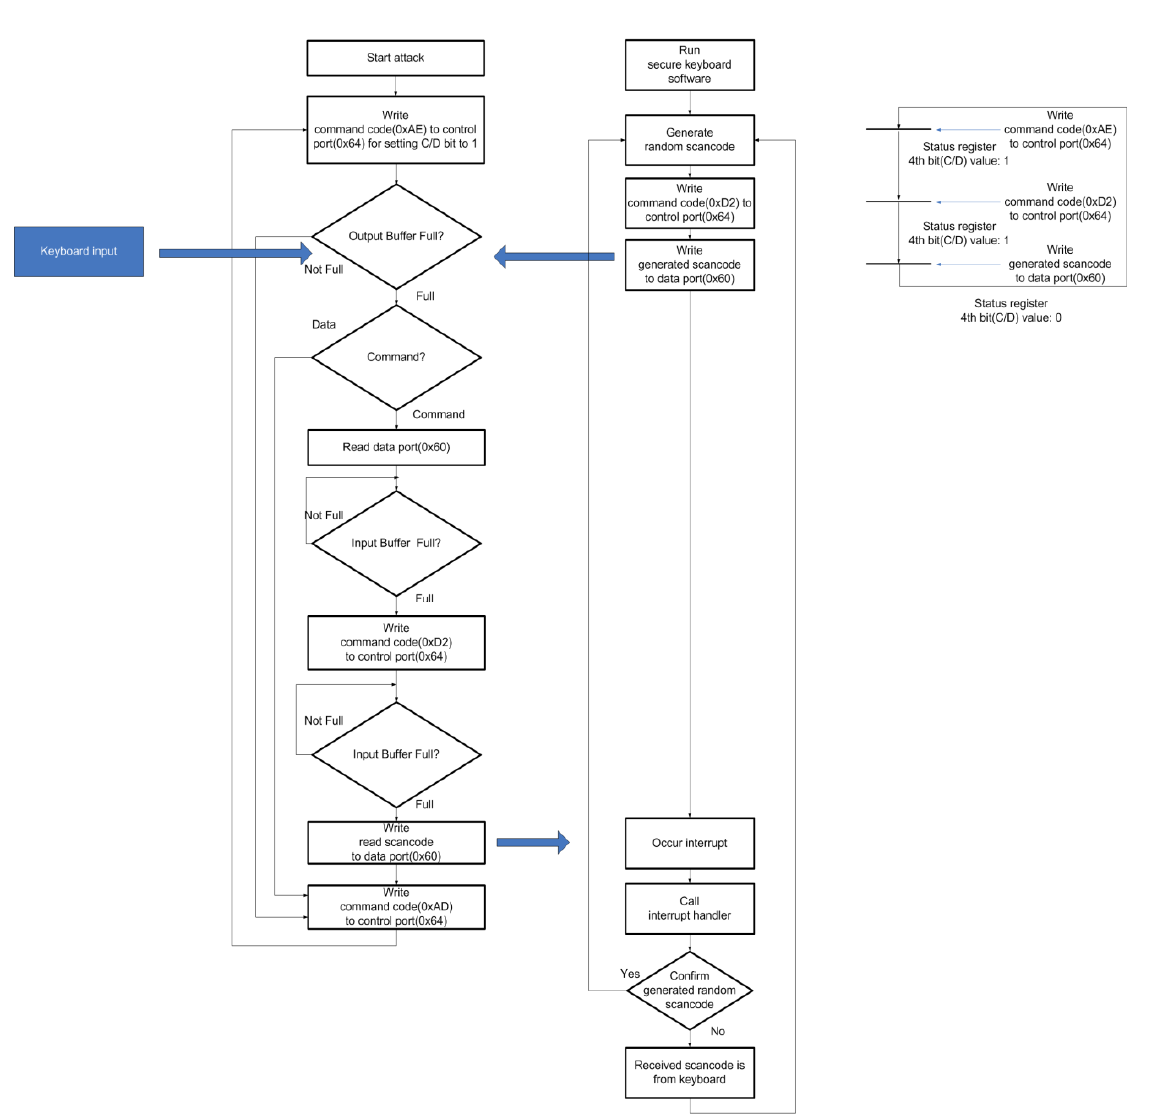
Figure 10. The attack technique using C/D bit